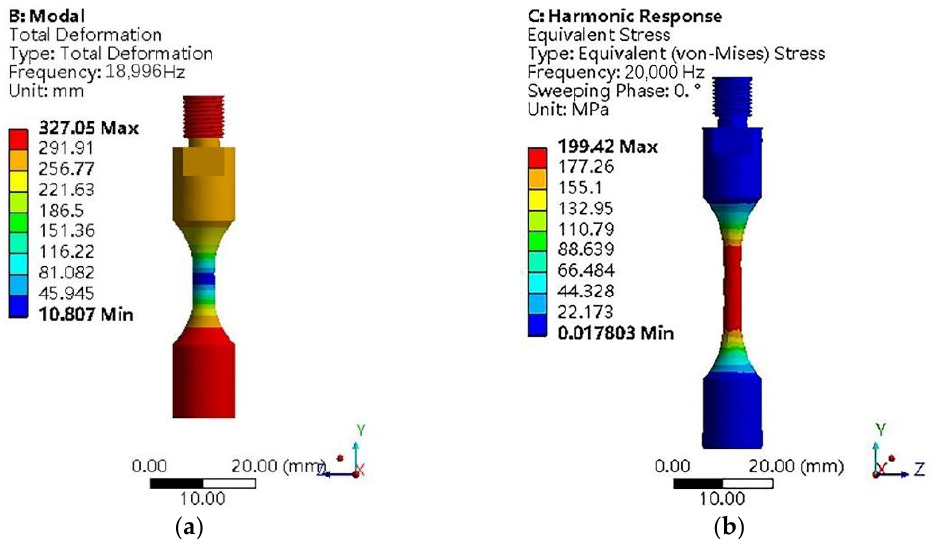
Figure 5. Finite element analysis results of an actual machined dog-bone-shaped sample: ( a ) Modal analysis; ( b ) harmonious response analysis.